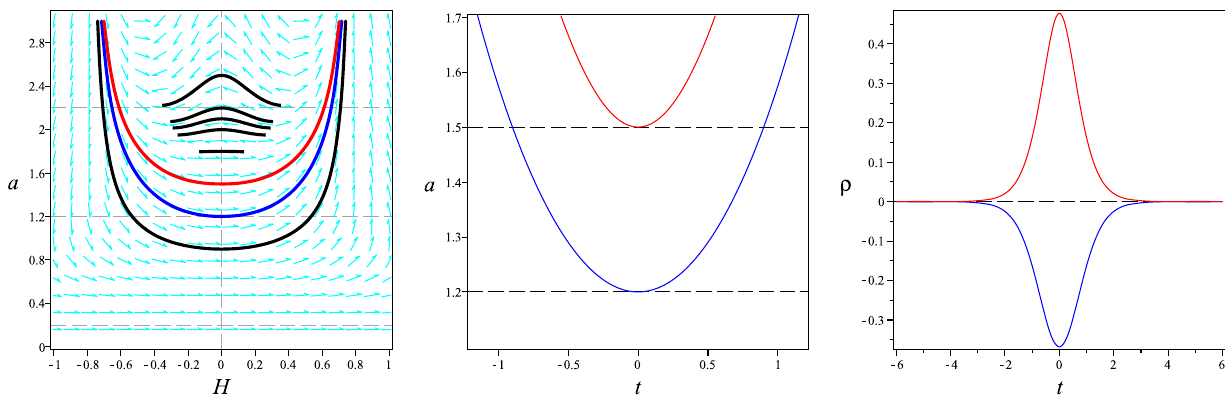
Fig. 4 (Left) dynamical behavior of the system around the critical points (Middle) time evolution of the scale factor corresponding to the red and blue trajectories. (Right) time evolution of the energy density corresponding to these trajectories